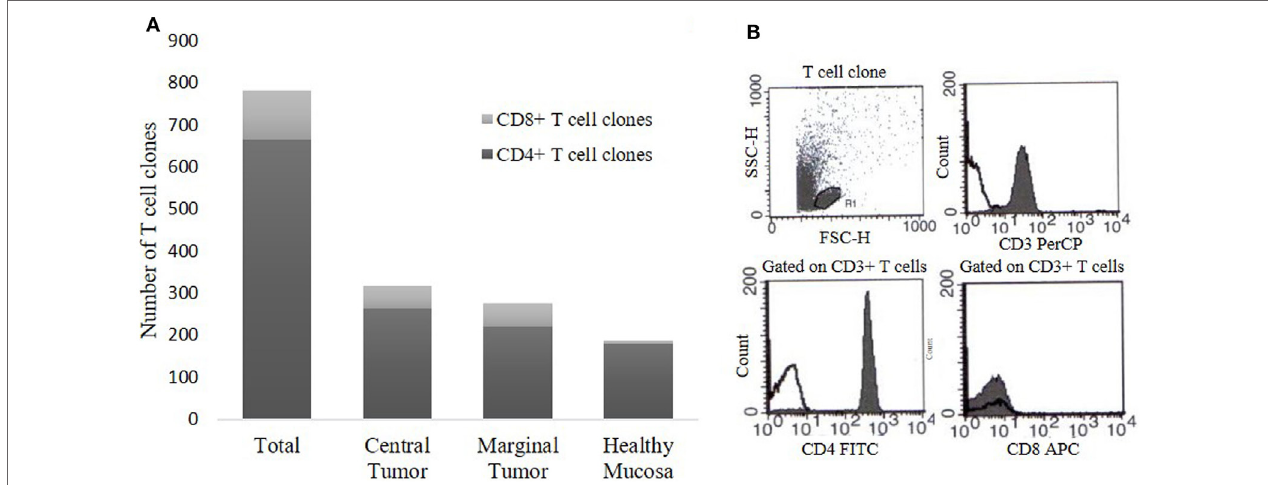
FigUre 1 | T cell clones (Tcc) obtained from colorectal cancer (CRC) patients. (a) The histogram represents the number of CD4 + and CD8 + Tcc isolated from the three different sites, namely central tumor, marginal tumor, and surrounding healthy mucosa. (b) A representative flow cytometry analysis of a CD4 + Tcc: anti-CD3, anti-CD4, anti-CD8 mAb (filled curve), or isotype control (empty